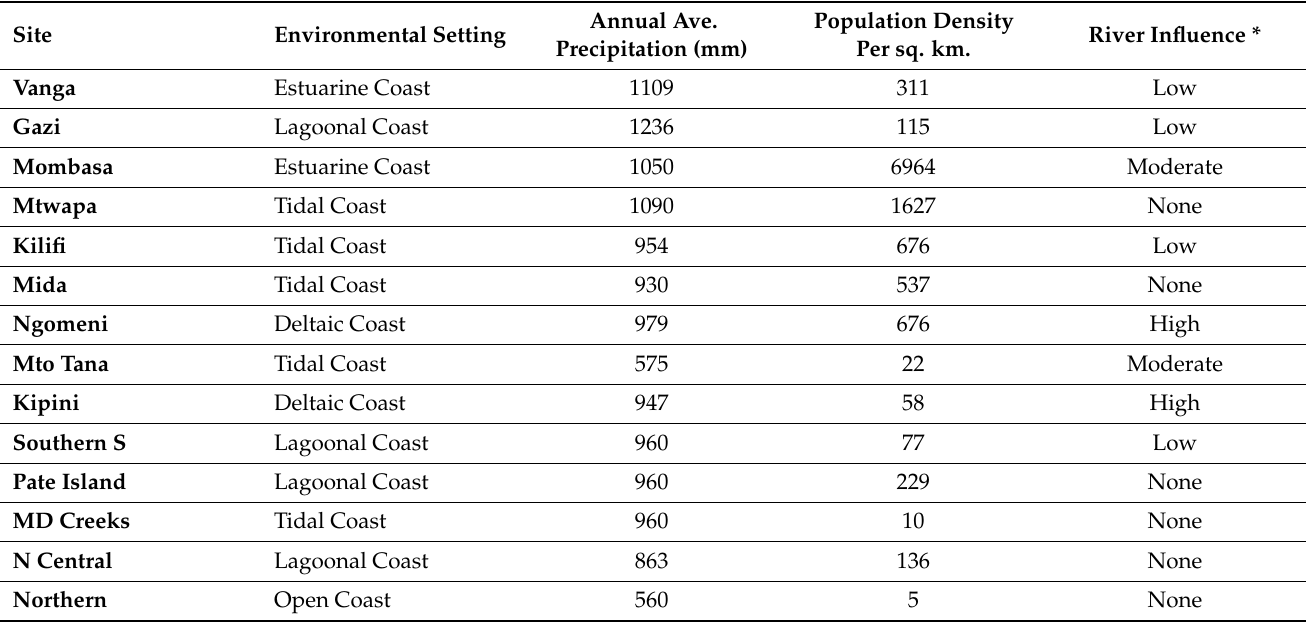
Table 1. Key characteristics of the sampled sites. Southern S denotes Southern swamps, MD Creeks— Mongoni Dodori Creeks, N Central—Northern Central